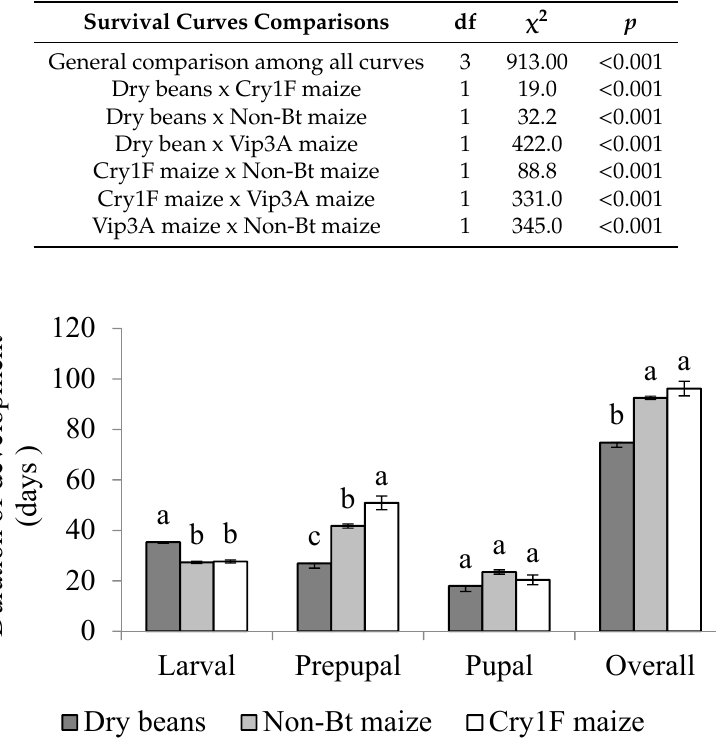
Figure 3. Mean larval duration (days ± SE) of S. albicosta , during each immature stage, from larvae reared on dry beans, non- Bt maize, and Cry1F maize under controlled conditions. Di ff erent letters indicate significant di ff erences between diets within a developmental stage ( p < 0.05). Means comparison based on Tukey’s